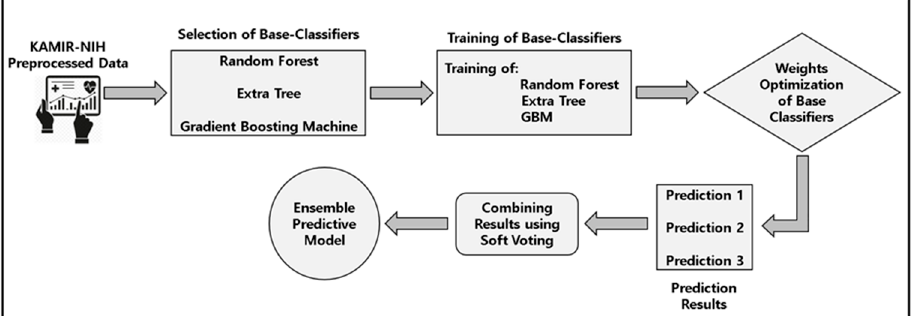
Figure 3. The soft-voting ensemble classifier for predictive modeling of ACS outcomes and mortality of patients.